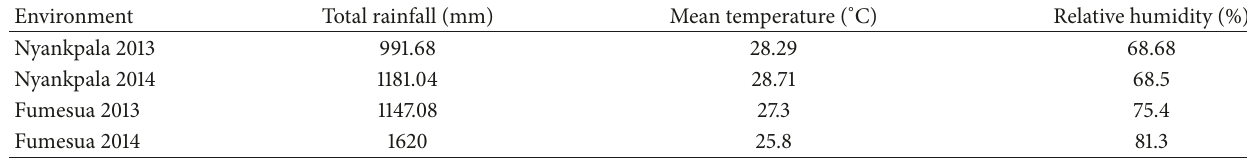
Table 2: Total rainfall, mean temperature, and average relative humidity during the period of the experiment. Environment